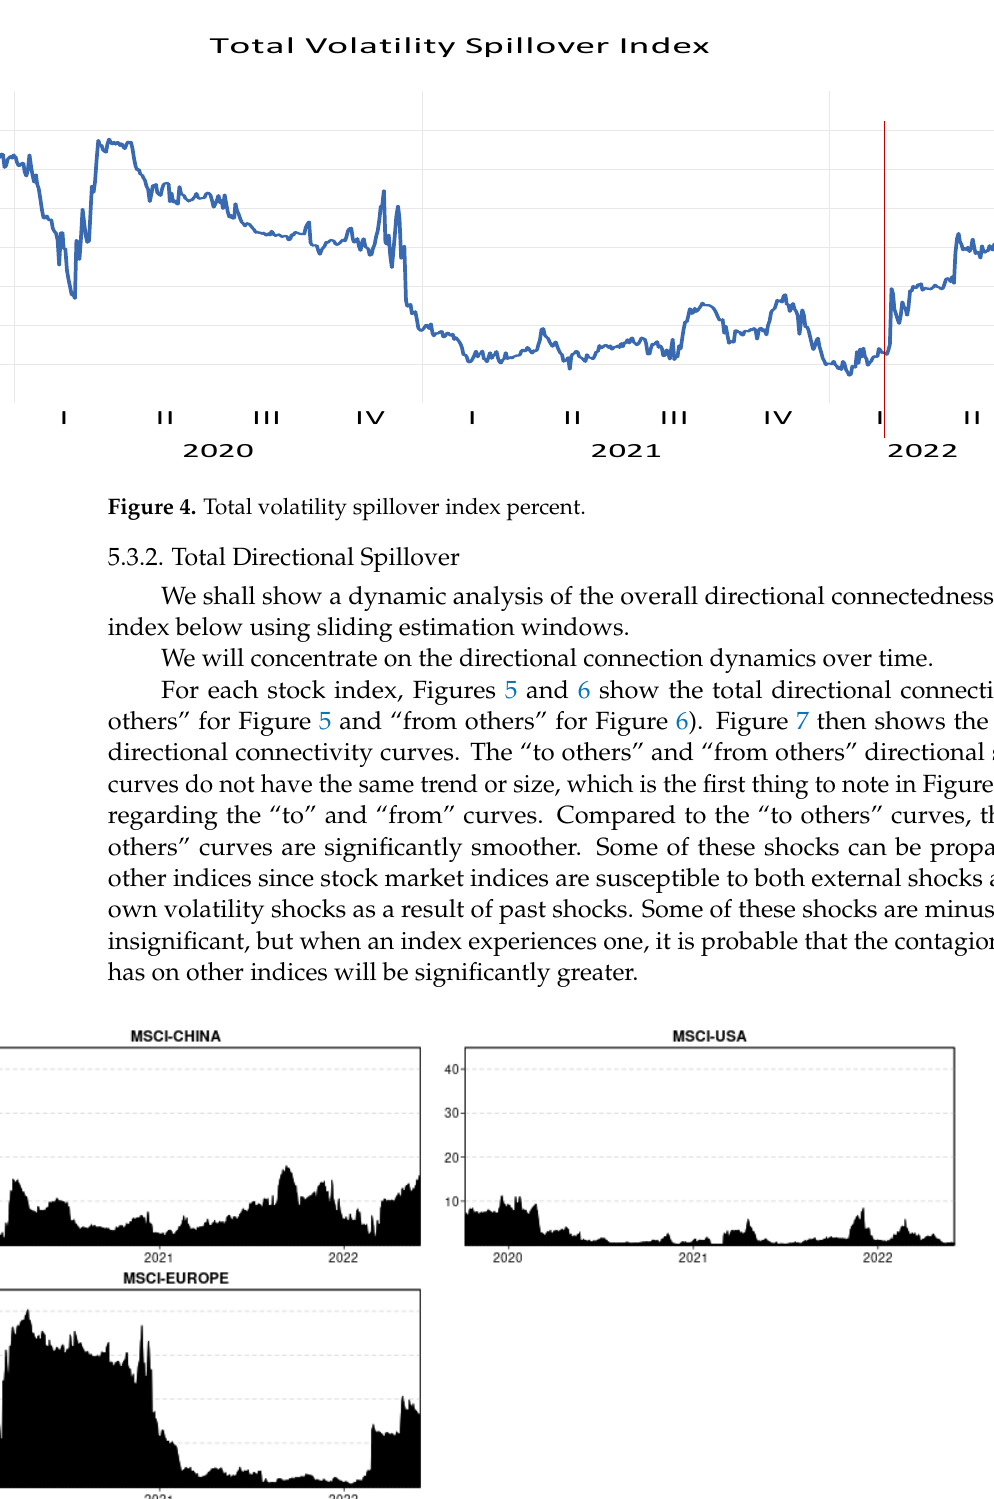
Figure 6. Directional volatility spillover to others. Figure 7. Net volatility spillovers.